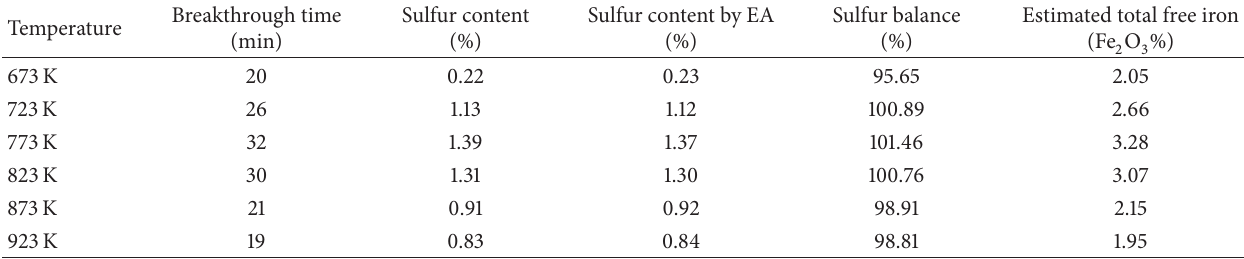
Table 2: The sulfurcapacities of theLoupi soil at various temperatures under the experimental condition of 50% H 2 and 1% H 2 S with balanced N 2